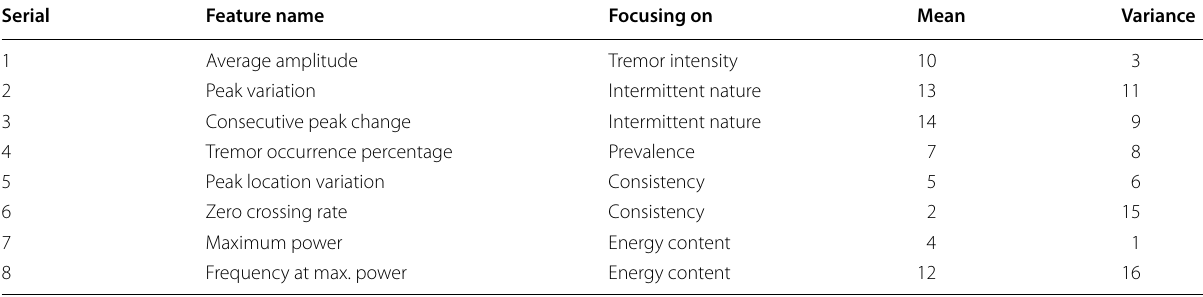
Table 4 List of features, their focus and ranks in analyzing rest tremor for PD detection